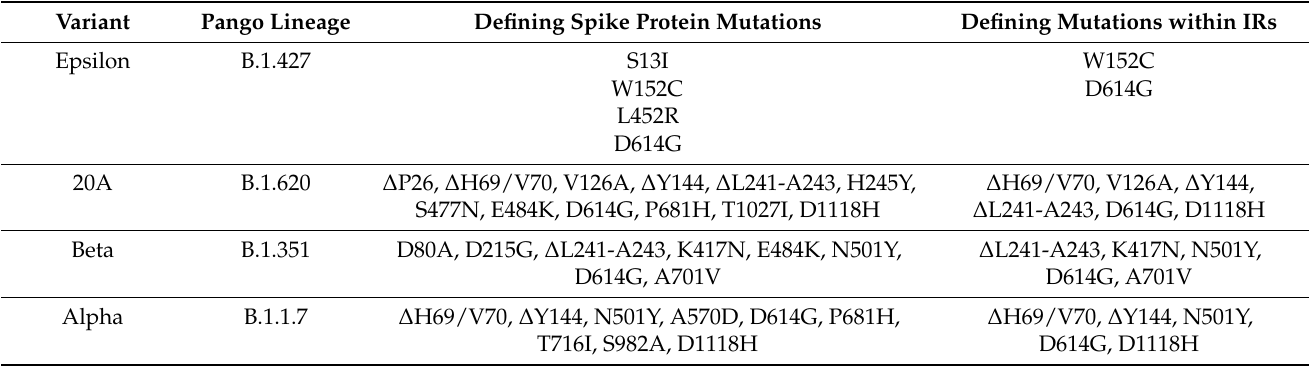
Table 1. SARS-CoV-2 variants studied and defining spike mutations containing inverted repeats